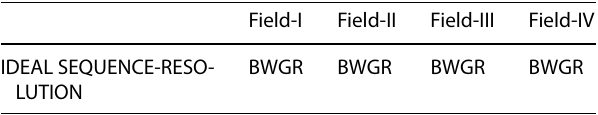
Table 2 Ideal resolution sequence (derived by digital image pro- cessing)